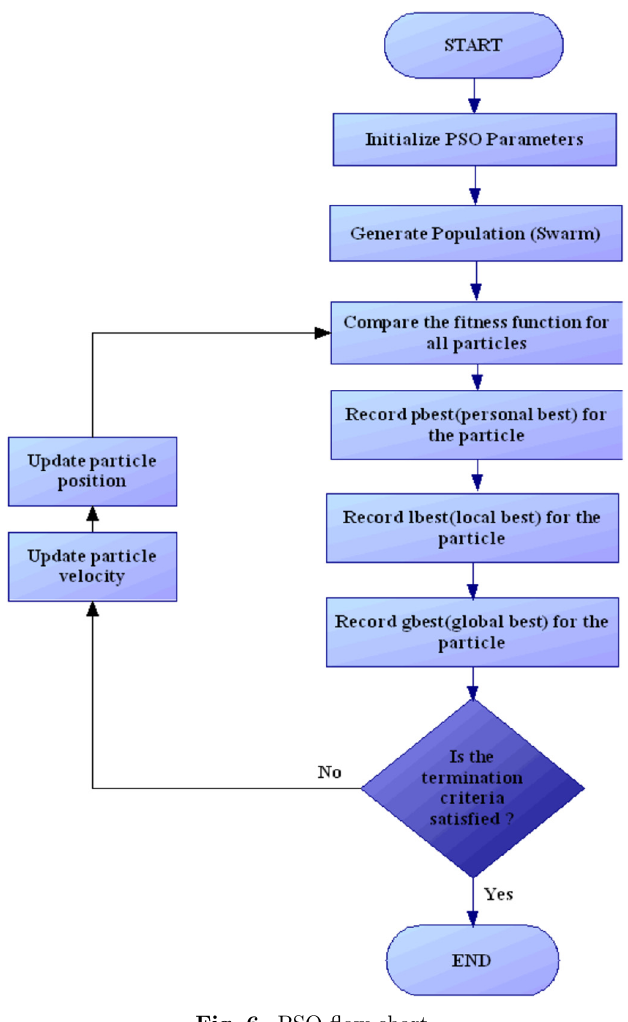
Fig. 6. PSO fl ow